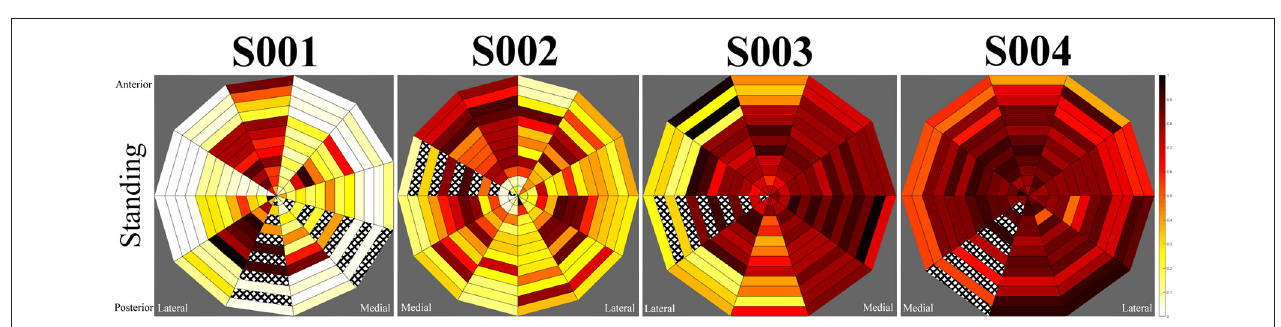
socket regardless of variation in common walking motions. Subject S003 displayed greater load variation on the mid-medial side of the socket, whilst subject S004 displayed lower loading of the proximal rim during left-turns and greater loading in the proximal rim during right-turns. The observed fluctuations appeared to align with a wider dynamic stance when this